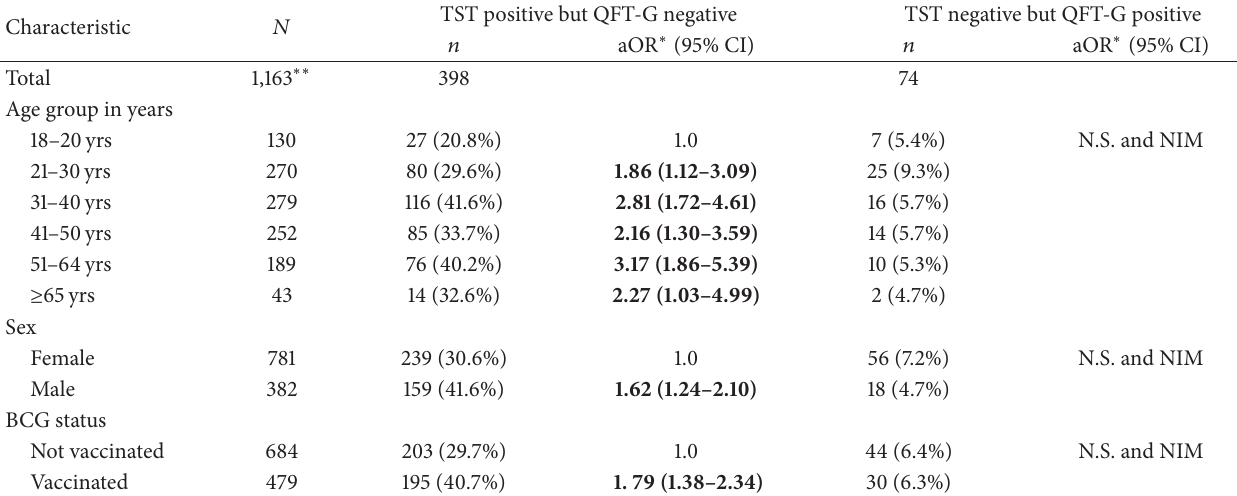
Table 5: Subject characteristics associated with TST and QFT-G discordance.